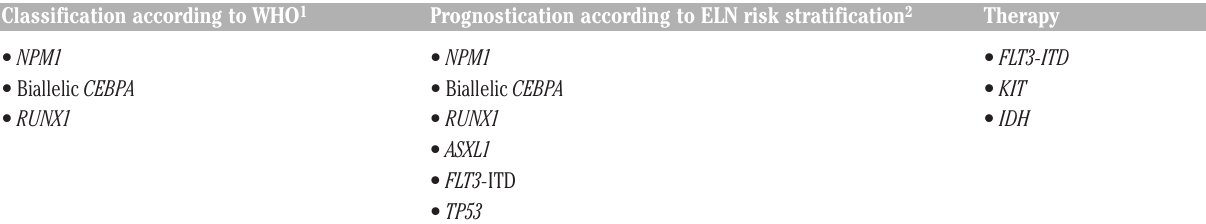
Table 1. Obligatory mutational analysis at diagnosis. Classification according to WHO